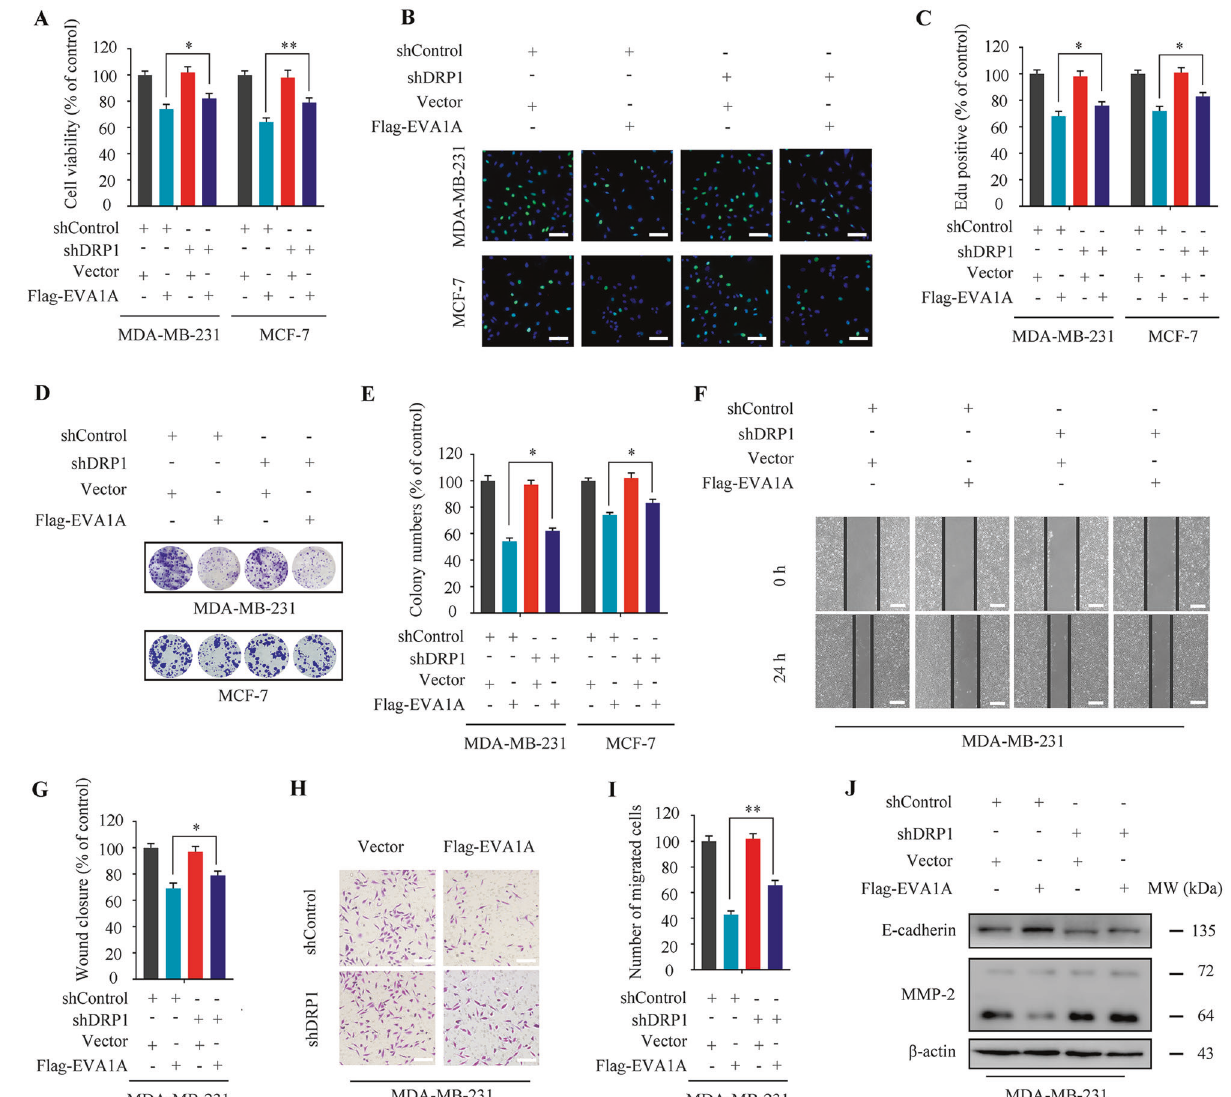
Fig. 8 Silencing DRP1 partially blocks the anti-proliferative and anti-migration effects of EVA1A overexpression in breast cancer. MDA- MB-231 and MCF-7 cells were co-transfected with DRP1 shRNA and Flag-EVA1A or vehicle control respectively for 48 h. A Cell viability was measured by MTT assay. B , C Representative images and quanti fi cation of Edu-positive cells were shown. Scale bar, 50 µm. D , E Representative images and quanti fi cation of colonies were shown. F , G The scratch assay was used to measure the migration capabilities of the cells. Representative images and statistics were shown. Scale bar, 100 µm. H , I Transwell assay was used to measure the number of migrated cells. Representative images and statistics were shown. Scale bar, 50 µm. J Immunoblotting of E-cadherin and MMP-2 expression. β -actin was measured as the loading control. Data represent mean ± SD. * P < 0.05, ** P < 0.01, *** P < 0.001. Statistical signi fi cance compared with respective control groups (all P -values were obtained by one-way